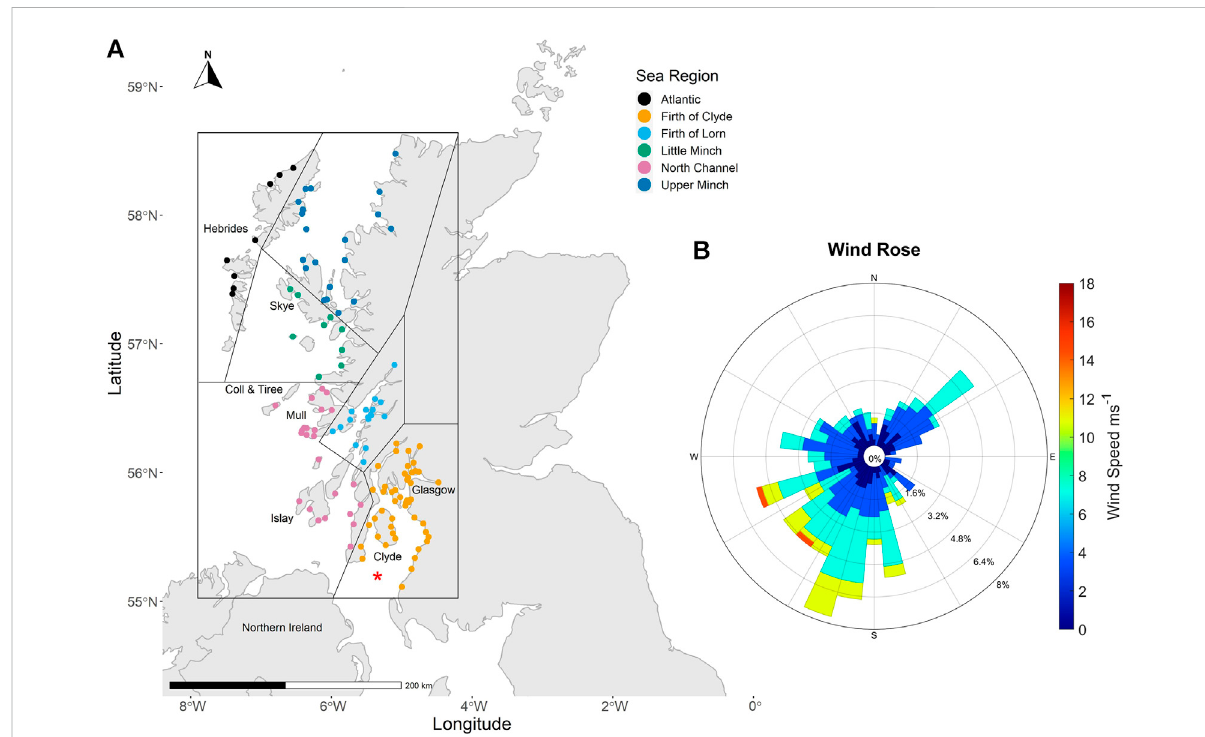
FIGURE 1 (A) :Beachsurveylocations ( n =127)onthewestcoastofScotlandconductedbytheMarineConservationSocietycitizen-sciencebeach-clean programme, between 1994 and 2019 (inclusive), colour coded by sea-region. The speci fi cboundaries are providedby the inner boundaries, and the model sub-area is de fi ned by the outer boundary. The survey locations are divided in relation to the Scottish Coastal Current (SCC), starting in the Firth of Clyde, and heading northwards through the North Channel, the Firth of Lorn, and into the Little Minch where the fl ow divides and turns westwards totheAtlantic orheadsnorth throughtheUpperMinch. (B) WindRoseofthedaily-averagedwindspeed(ms − 1 )anddirection(from which the wind blows), for the year 2020. Wind speed was interpolated from the local high-resolution weather forecast model (WRF), at coordinates to 5.34 ° W, 55.20 ° N, in the Clyde Sea, marked by the red asterix in (A) . The main islands are labelled to provide reference to their geographical